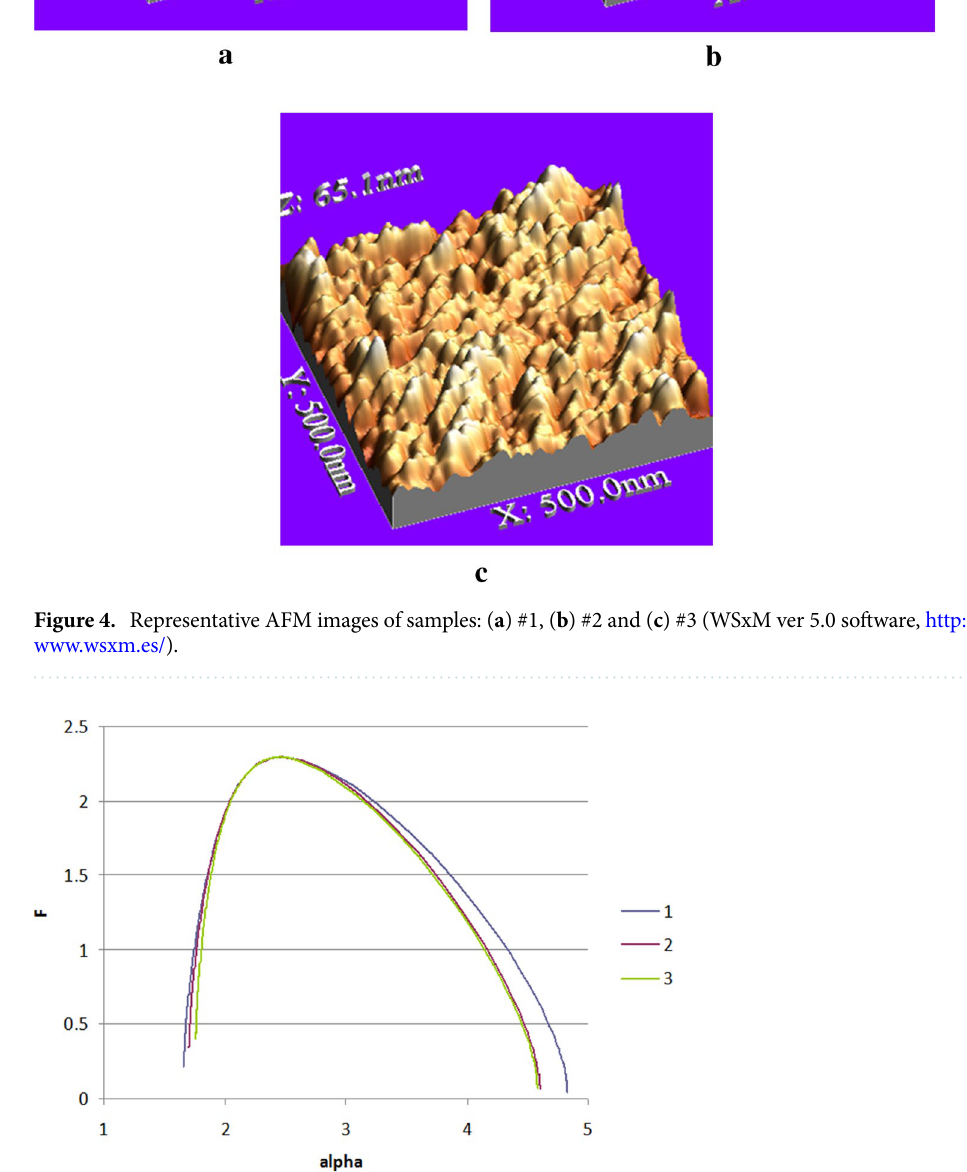
Figure 5. The graphical representation of RMS roughness of samples #1, #2 and #3 deposited at various times 10, 25 and 40